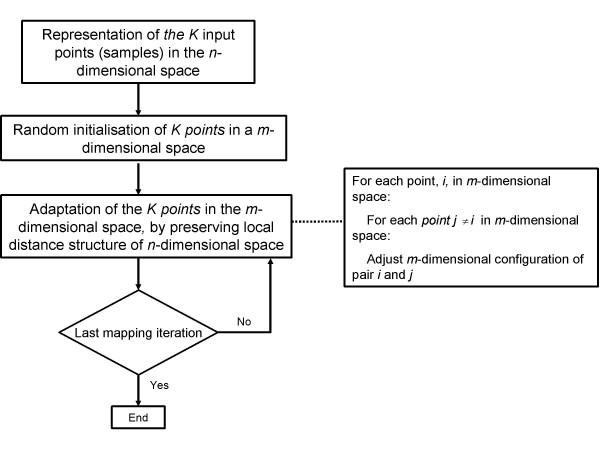
Relaxation method for non-linear mapping. The input to the algorithm is a collection of K points described in an n-dimensional space. A mapping iteration refers to a complete sequence of adaptation steps involving pairs of points, p(i,j). A point may encode a biological sample described by a gene expression profile (e.g. tumour sample), or a protein described by an interaction profile.